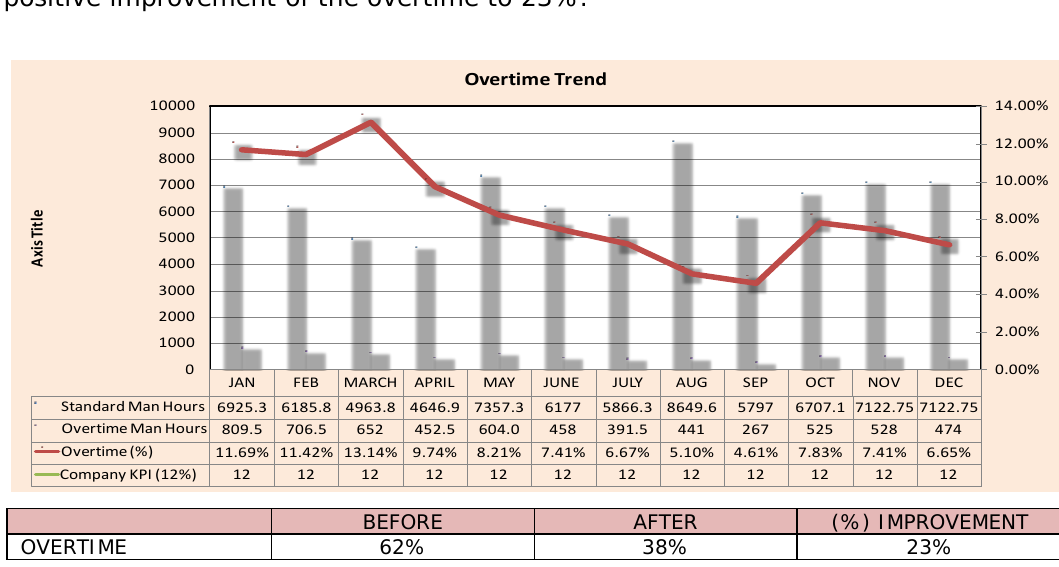
Figure 13. “Percentage of improvement for Overtime